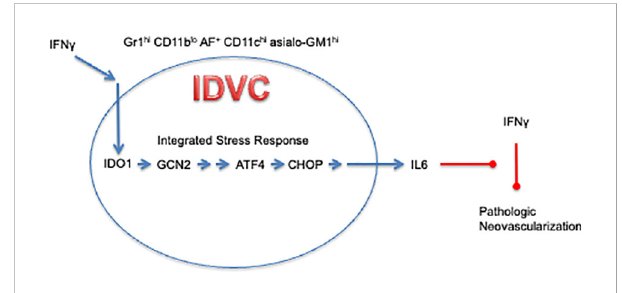
FIGURE 1 IDO1-Dependent Vascularizing Cells contravene the ability of IFN g to regress neovascularization through IDO1-mediated induction of